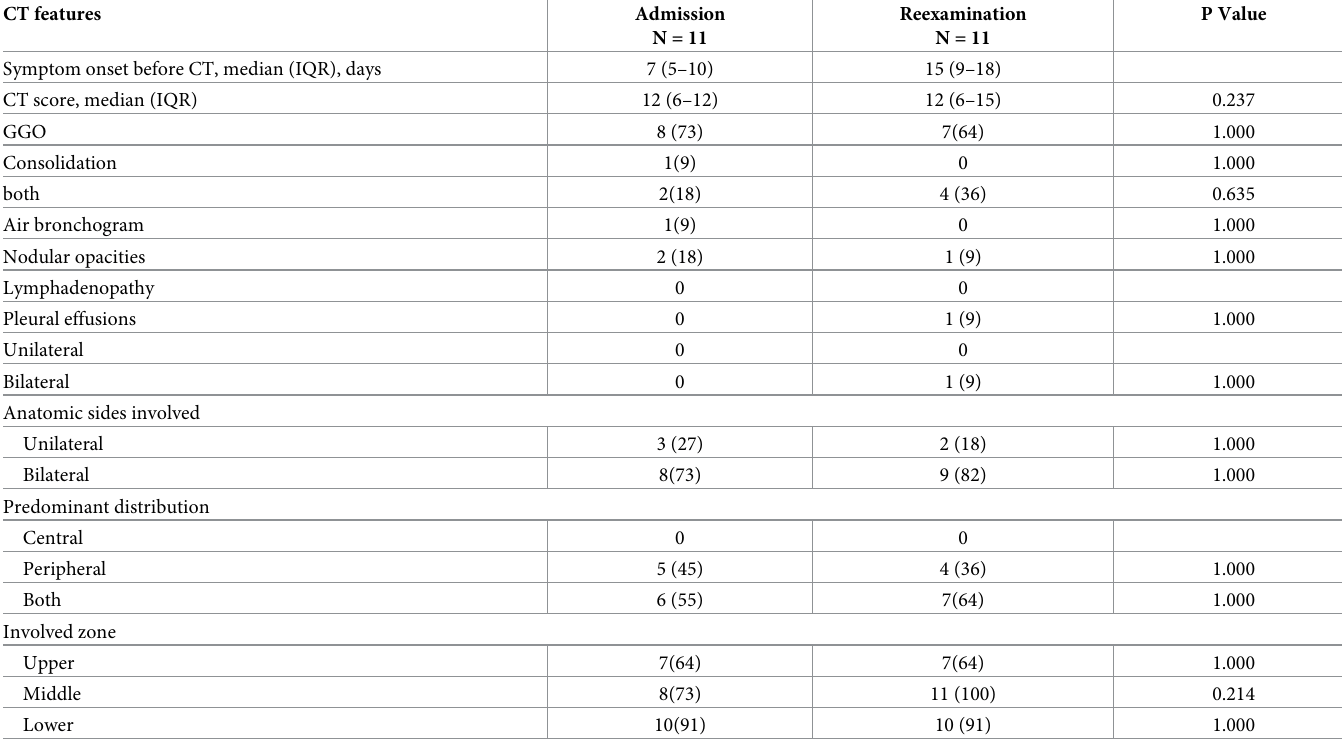
Table 3. Comparison of CT features in survival group between admission and reexamination.